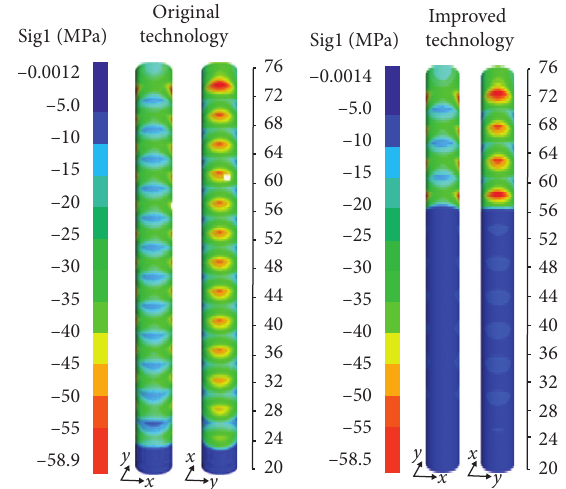
Figure 14: Longitudinal stress distribution in surrounding rock after adjusting construction